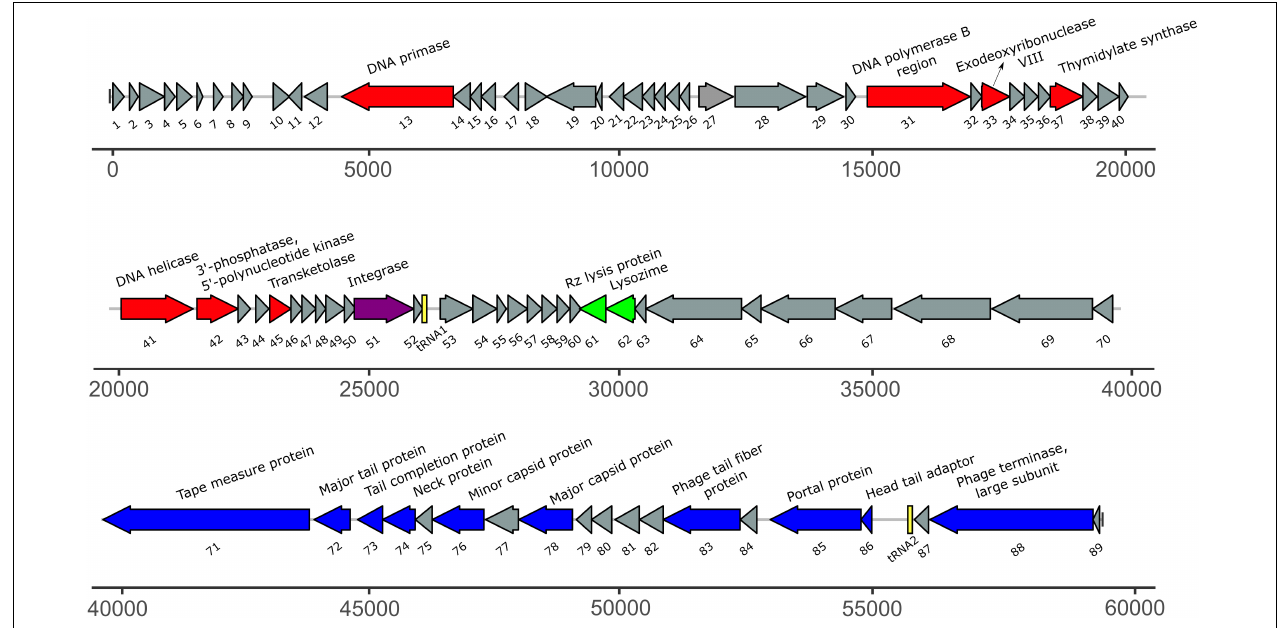
FIGURE 7 | The annotated draft genome of Acidovorax phage ACF1. The ORFs coding for proteins involved in DNA replication/modification/transcriptional regulations are marked in red; ORFs coding for structural proteins are marked in blue; ORFs coding for enzymes involved in host lysis are marked in green; ORF coding for recombination protein is marked in purple. ORFs coding for hypothetical and phage proteins are marked in gray while tRNAs are marked in yellow. Arrows indicate the direction of transcription and translation. Unit of the presented draft genome annotation is in